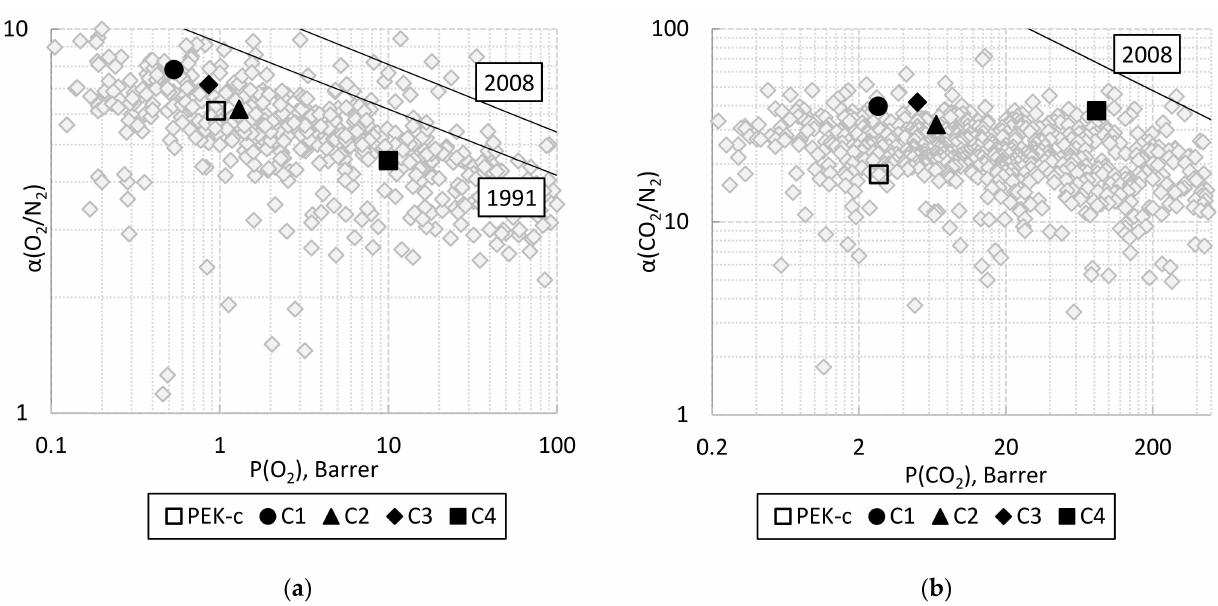
Figure 6. Robeson diagrams for oxygen–nitrogen ( a ) and carbon dioxide–methane ( b ) for the studied polymers. For comparison, the data for poly(arylene ether ketone) PEK-c are given [69] (data from [69] are similar to those from [70]). Upper bounds are provided from [7] (1991) and [8]